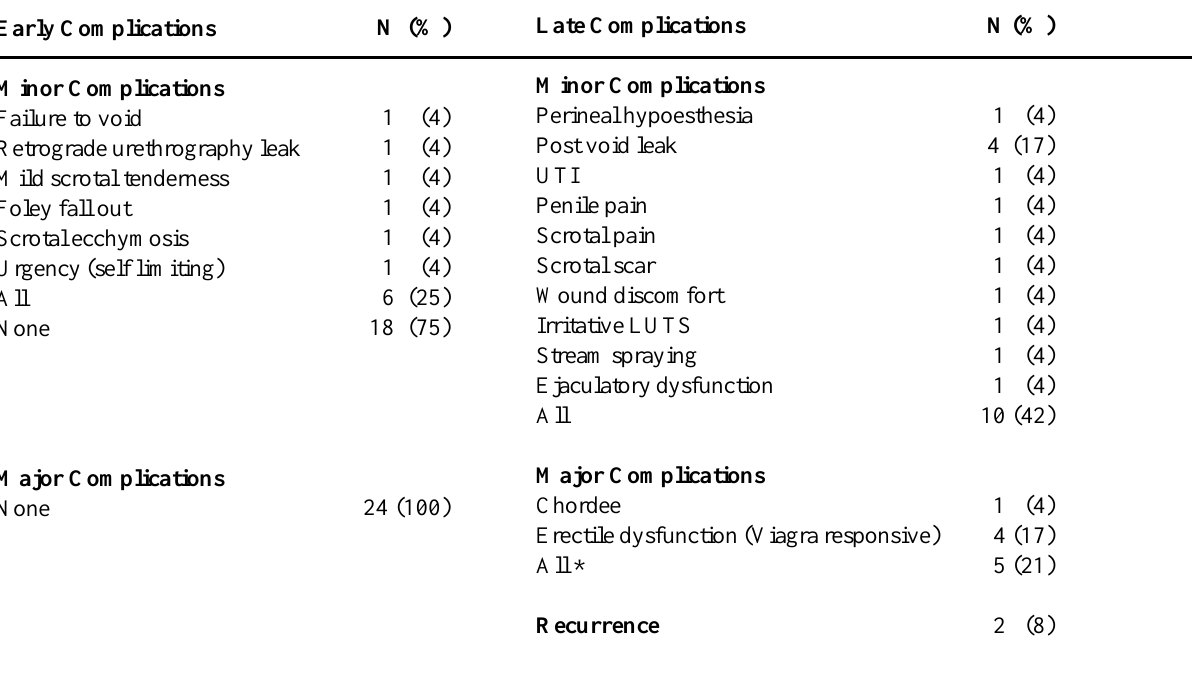
Table 2 – Anterior anastomotic urethroplasty complications, n = 24.